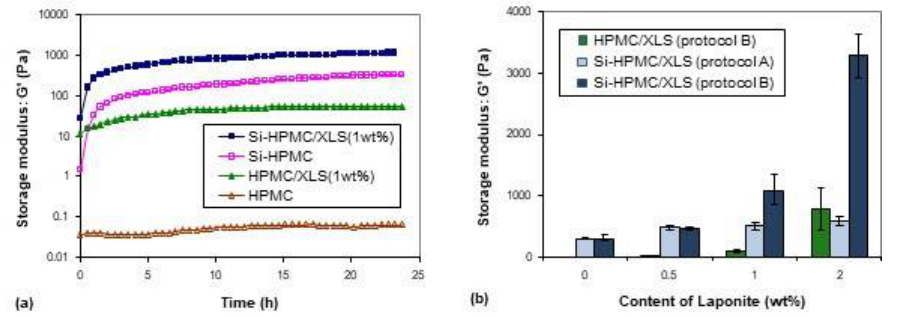
Figure 1. ( a ) Evolutions of storage modulus of different systems with time. Composite hydrogels were